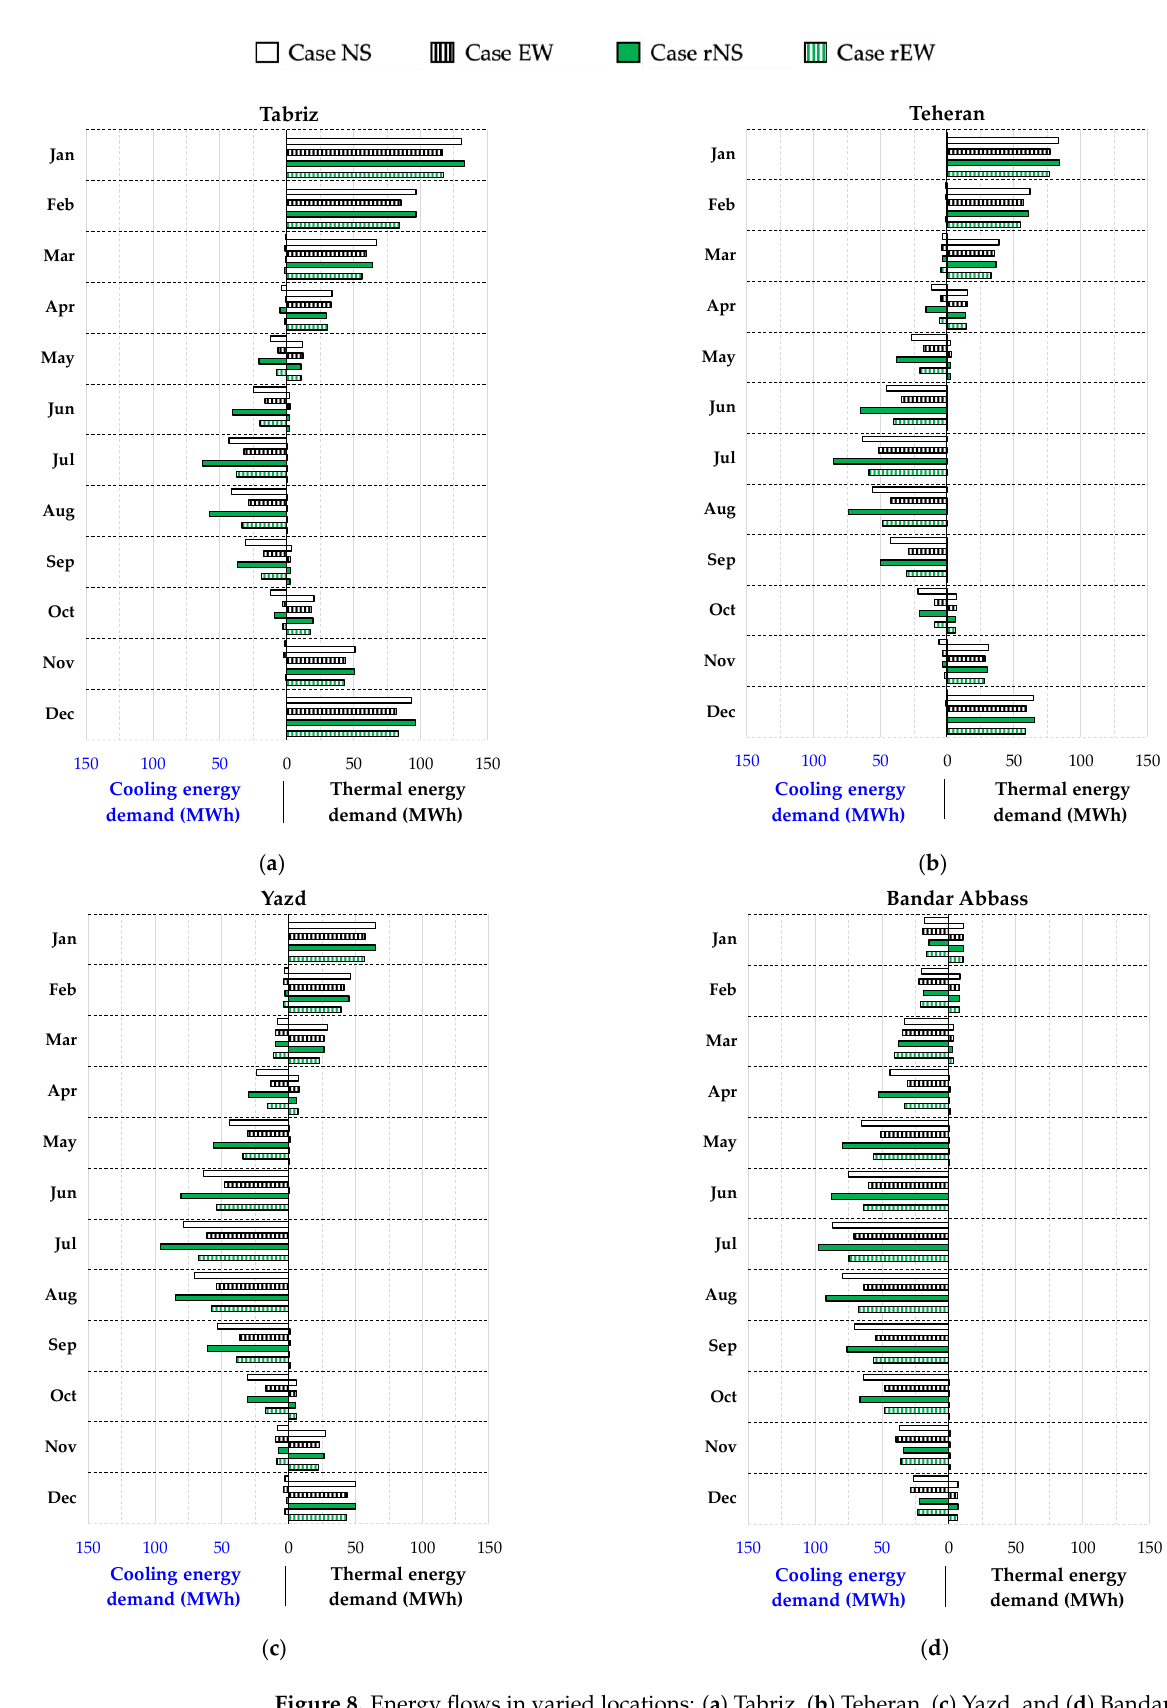
Figure 8. Energy flows in varied locations: ( a ) Tabriz, ( b ) Teheran, ( c ) Yazd, and ( d ) Bandar Abbas.